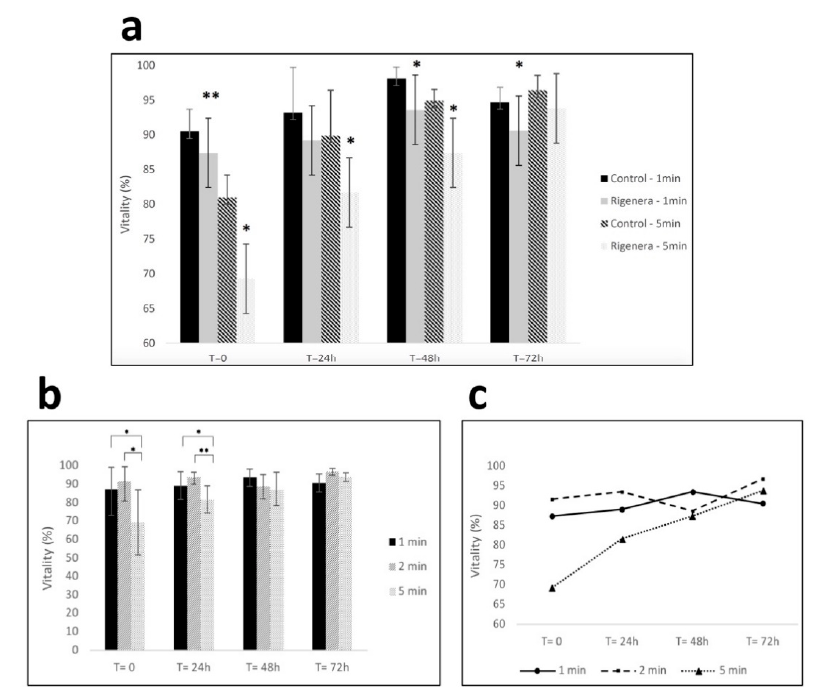
Figure 1. ( a ) Fibroblast viability for control and samples processed with Rigenera ® for 1-min and 5-min. Significant differences in viability between control and processed cells are indicated as * p < 0.05 or ** p < 0.01. ( b , c ) Viability of fibroblasts at 0/24/48/72 h time points after being processed with Rigenera ® for 1, 2 and 5 min. Statistical significance is given as follows: * p < 0.05; ** p < 0.01.